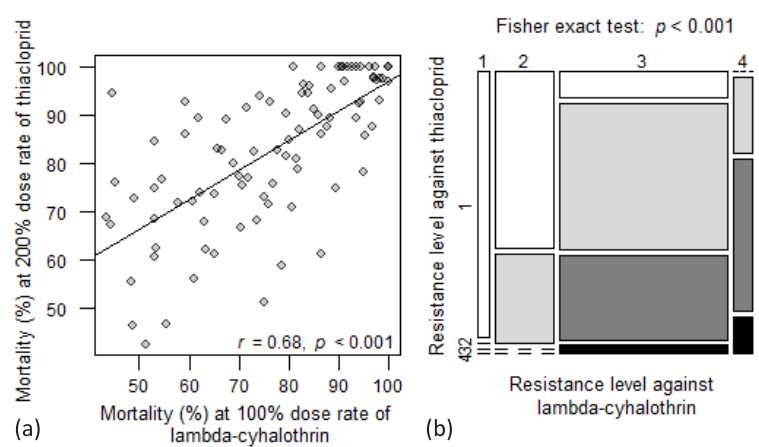
Fig. 4a. The relationship between mortalities at a 100% dosage rate of lambda-cyhalothrin and a 200% dosagerate of thiacloprid; presented numerically is a linear correlation coefficient with p -value. Fig. 4b. The concordance between resistance levels in populations against lambda-cyhalothrin and thiacloprid; level 4 denotes highly resistant populations and level 1 denotes susceptible, according to IRAC No 011, while level 4 shows reduced susceptibility populations and level 1 shows highly susceptible populations according to IRAC No 021 (IRAC 2015) and Kaiser et al.